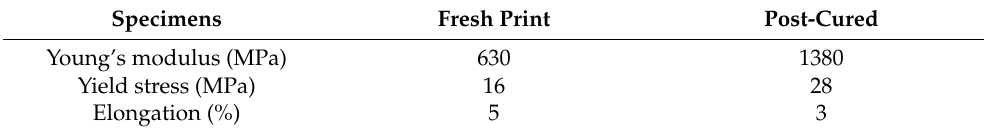
Table 2. Mechanical properties of PR48.